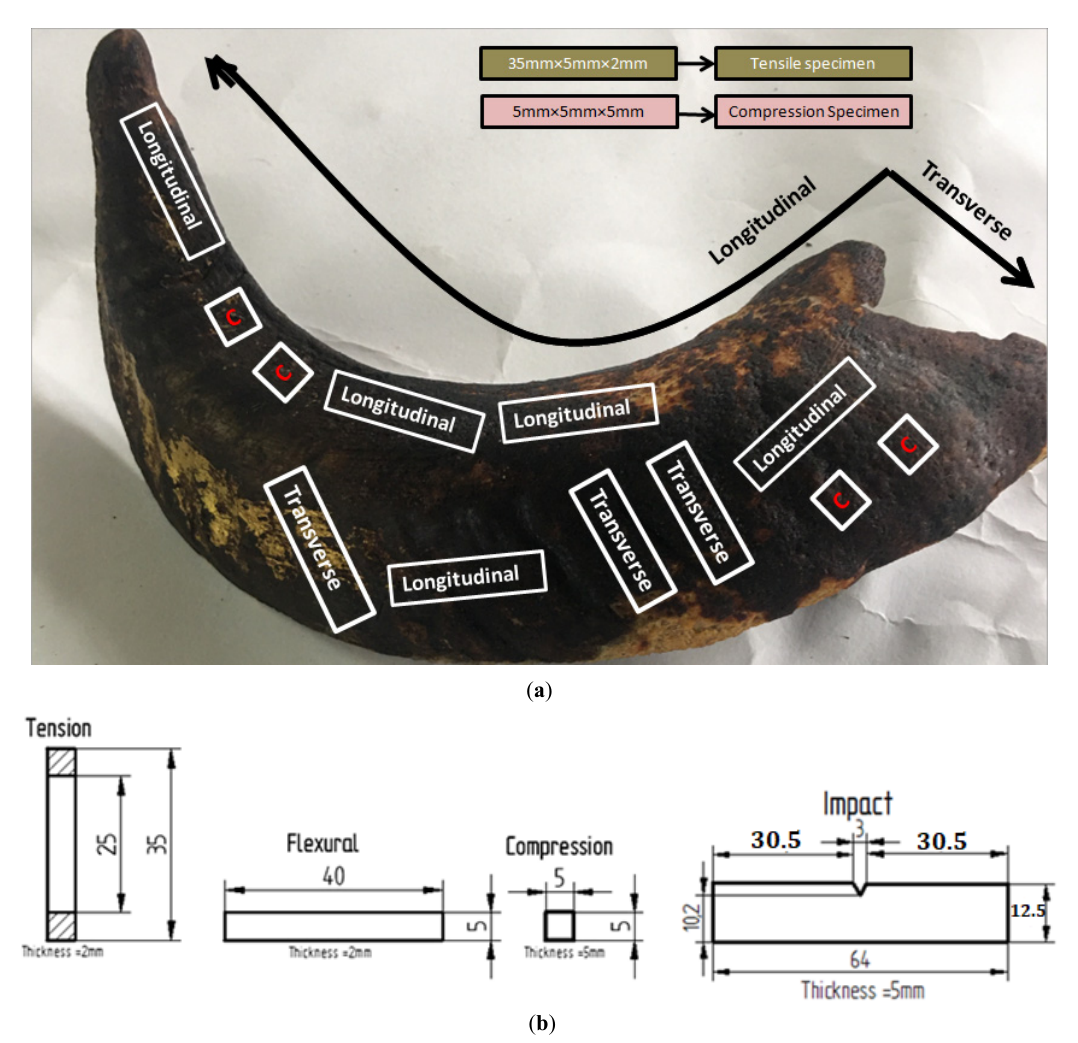
Figure 2. ( a ) A pattern of slicing for extraction of coupons and ( b ) ASTM standard used for slicing the horn